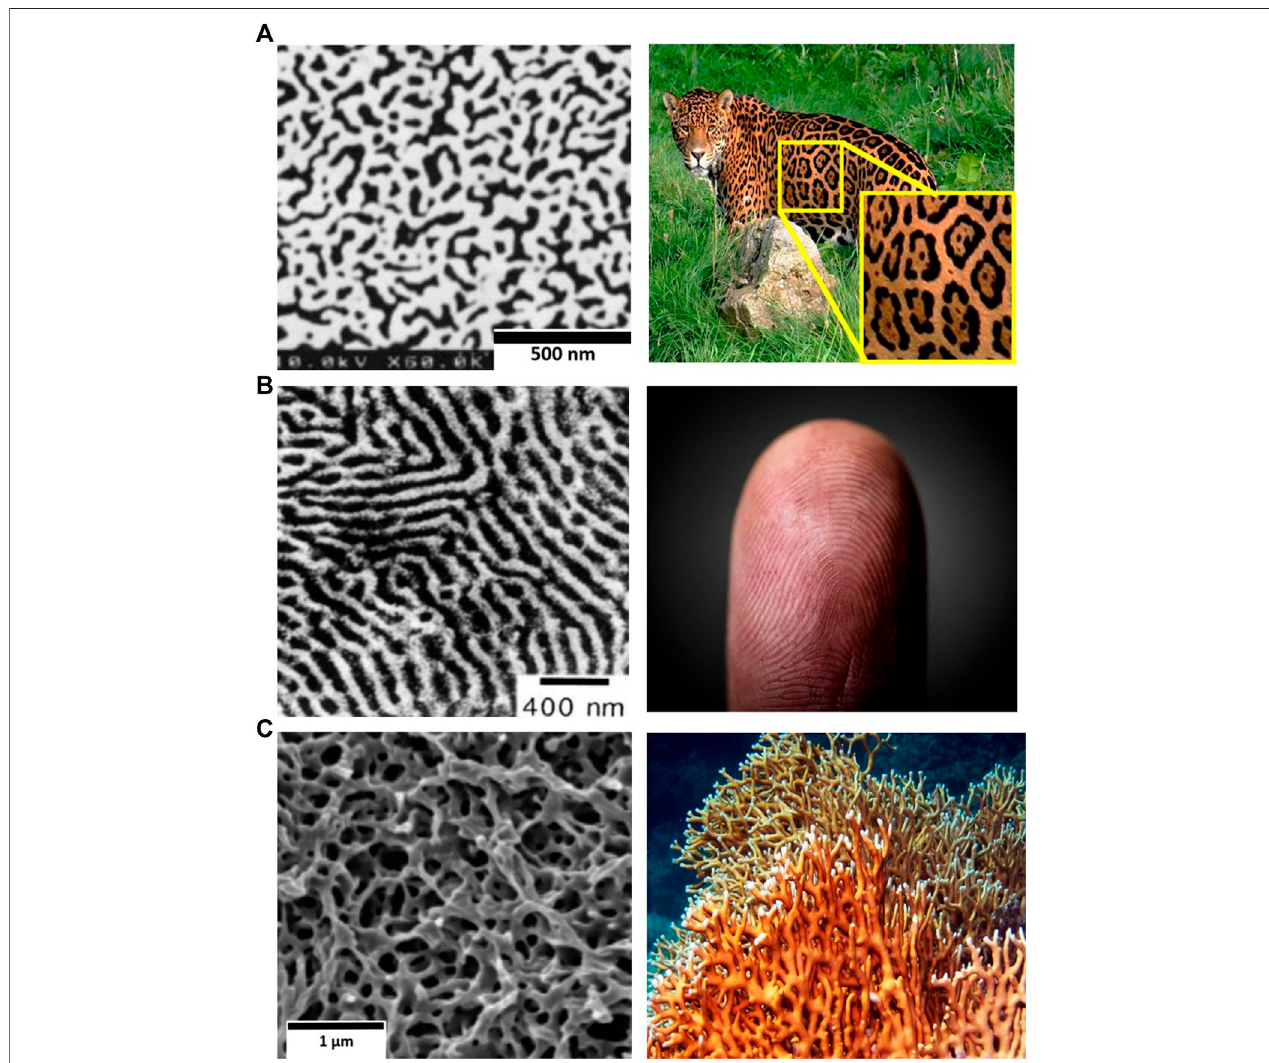
FIGURE 2 | Examples of nanostructured polymeric materials obtained in bicontinuous microemulsion: (A) SEM image of transparent nanostructured polymer of MMA/AUTMAB (Reprintedwith permission from Langmuir 1998, 14,21, 6068 – 6076. Copyright (1998) American Chemical Society)Chewet al.(1998) compared tothe spot pattern ofa feline ( “ Jaguar ” by Chester Zoo islicensed under CC BY-ND 2.0). (B) TEM image of thebicontinuous polymeric material ofPE-PEP/PE/PEP (Reprinted withpermission from Phys.Rev.Lett. 79,849.Copyright(1997)bytheAmericanPhysicalSociety),compared witha fi ngerprint(Copyright: IvanRadic.Close-upof a fi ngerprint on a human fi nger. Available on: https://www. fl ickr.com/photos/26344495@N05/49463377503. Visited on August 2021). (C) SEM image of nanoporous polyethylene(PE) polymeric structure (Reprinted withpermission from Chem. Mater. 22(2010) 1279 – 1281.Copyright(2010) AmericanChemical Society), compared to thestructure ofa Milleporadichotoma coral(This fi leisavailableundertheCreativeCommonsAttribution2.0Genericlicense.Availableon:https://es.wikipedia.org/wiki/ Millepora#/media/Archivo:Fire_Coral.jpg. Visited on: August 2021).